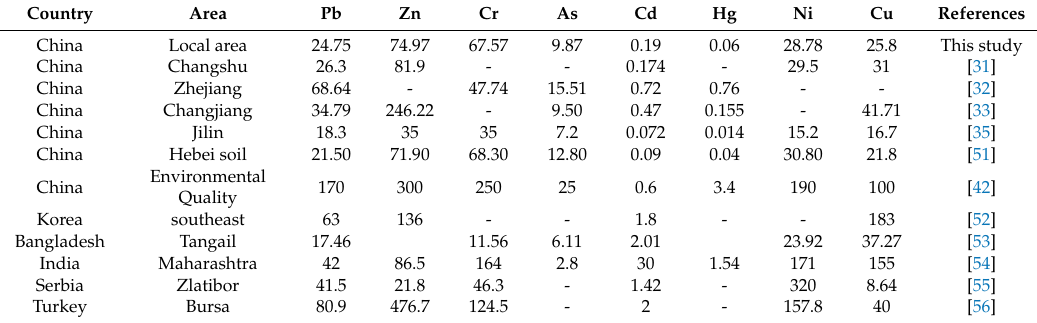
Table 3. The comparison of trace metal(loid)s in local area with others region (unit: mg / kg).